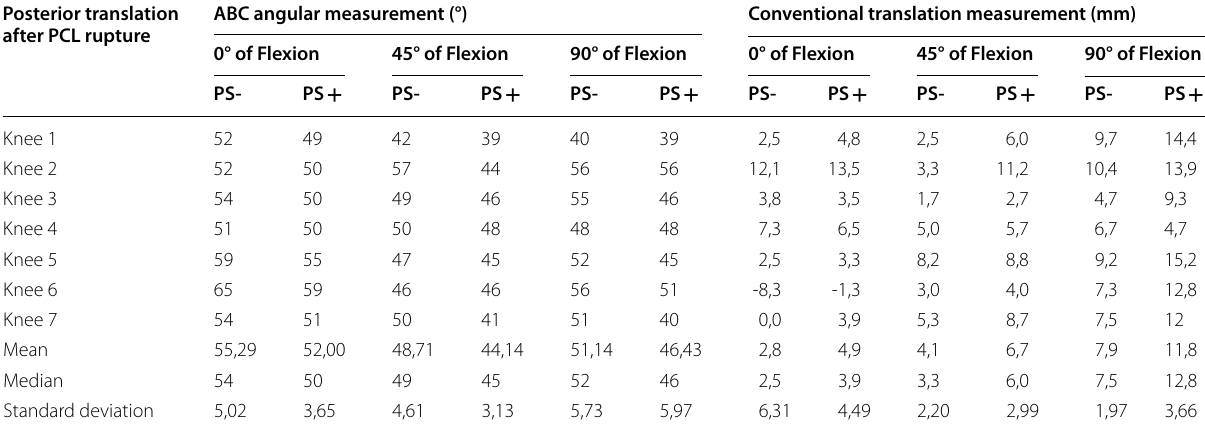
Table 1 Angular measurement (ABC angle) and conventional distance measurement with and without posterior stress after posterior cruciate ligament section Posterior translation after PCL rupture